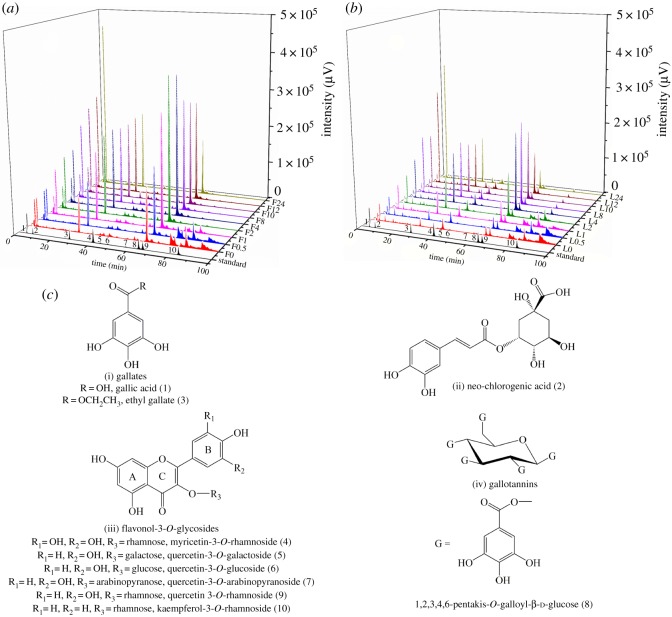
HPLC fingerprints of ATL (a) and ATF (b) during the thermal treatment as well as the mix standards of the 10 major phenolics, together with the chemical structure of the 10 major phenolics (c). Chromatographs of ATF, ATL and mixed standards (black curve) were obtained under the same HPLC conditions. ‘L’ and ‘F’ in the Z axials in (a) and (b) represent ATL and ATF, respectively, and the number following ‘L’ and ‘F’ represents the thermal treatment duration. Numbers 1–10 in (a) and (b) correspond to those in (c).